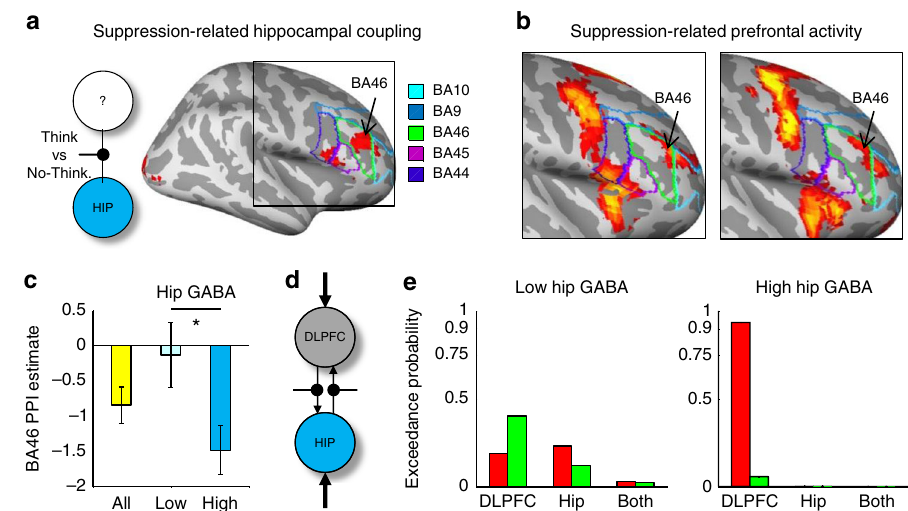
Fig. 3 Hippocampal GABA predicts DLPFC-Hippocampal connectivity during thought suppression. a Schematic of psychophysiological interaction analysis (PPI) with hippocampal (HIP) seed and conditions modulating HIP connectivity. Signi fi cant PPI effects arose in right lateral prefrontal cortex: Brodmann ’ s area (BA) 46/9 (DLPFC) and BA45 (VLPFC), displayed as colored boundaries (see legend). b DLPFC activity during suppression (No-Think > Think) in the current (left) and in a prior study 31 (right) overlapped with the PPI effects. c Functional connectivity: Suppression negatively modulated fronto-hippocampal coupling (PPI estimate, y axis), with the strength of negative coupling differing between low- and high-GABA subgroups (Independent samples t -test, * p < 0.05). Error bars represent standard error of the mean. d The six bidirectional dynamic causal models of the DLPFC – HIP network varied according to two parameters: Which Task modulated connectivity (horizontal lines: No-Think or Think) and source of Driving Input (Outer arrows: DLPFC, HIP, or BOTH). e Effective connectivity: for Low GABA participants, no clear evidence for a role of DLPFC in modulating connectivity emerged in any model. For high hippocampal GABA participants, model evidence (exceedence probabilities) favored a model with inputs to DLPFC driving the network and